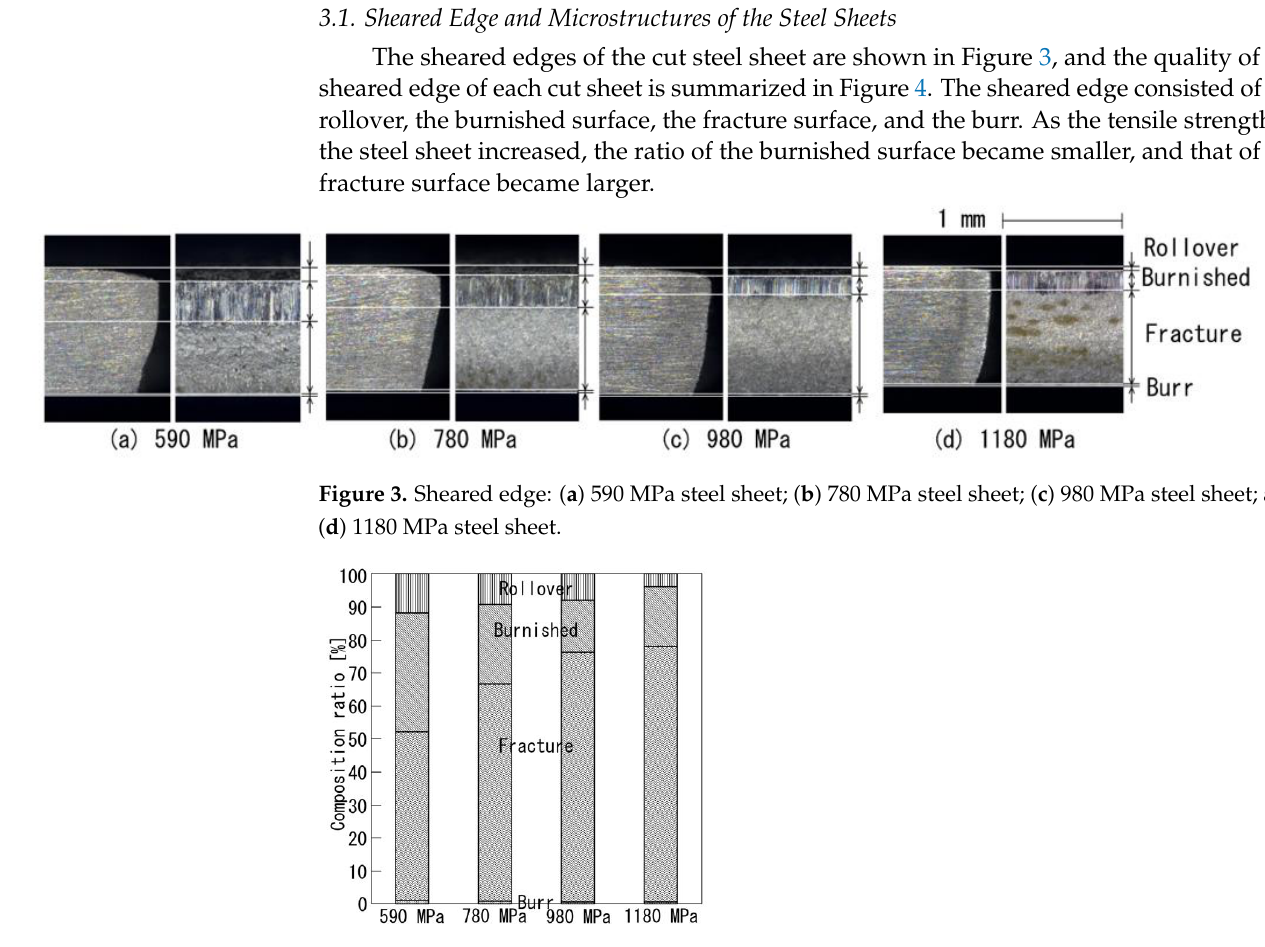
Figure 2. Method of investigating magnetic flux density of magnetized and demagnetized sheets before and after shearing.